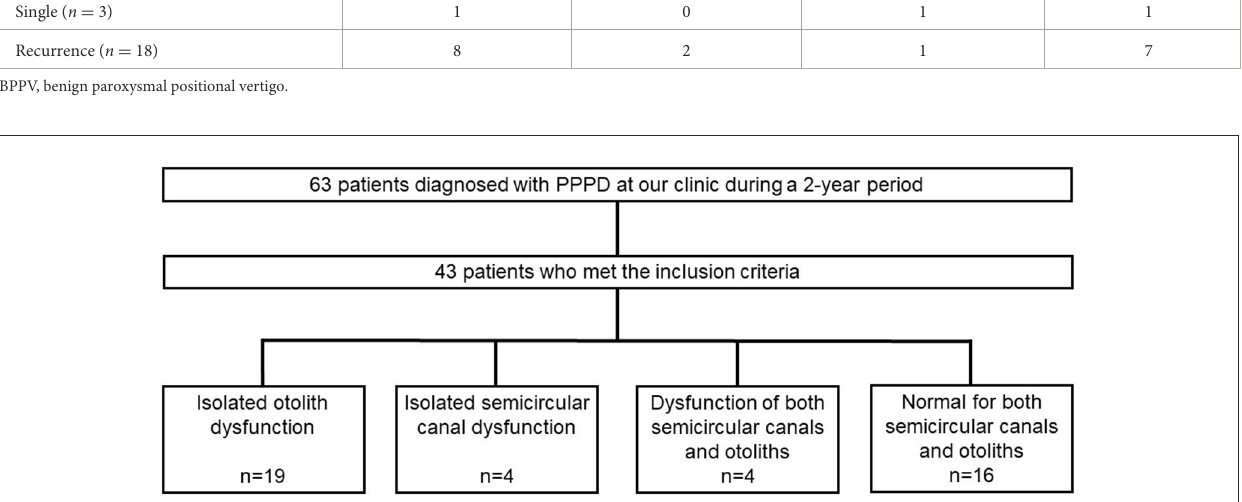
FIGURE1 Flow diagram for study patients and classification by vestibular function tests.